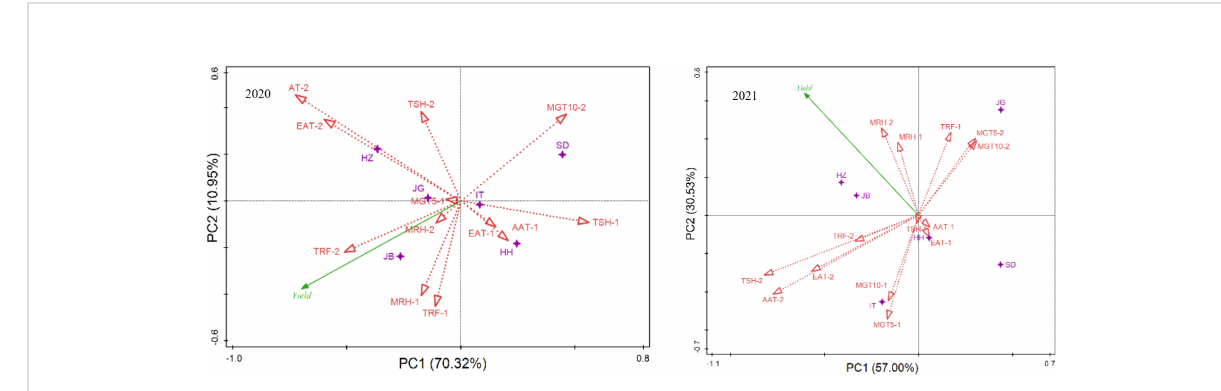
FIGURE 4 Relationship of location and ecological factors revealed by RDA analysis of yield. EAT, effective accumulative temperature; AAT, accumulative average temperature; AGT5, average 5-cm ground temperature; AGT10, average 10-cm ground temperature; ARH, average relative humidity per day; TRF, total rainfall; TSH, total sunshine. -1, stage from emergence to fl owering; -2, stage from fl owering to